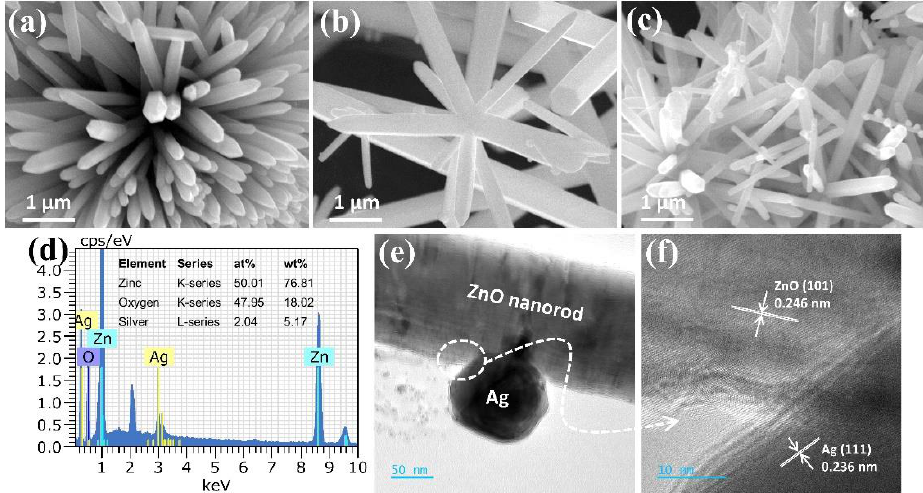
Figure 2. SEM image of pure ZnO ( a ), 2% Ag-ZnO ( b ), and 5% Ag-ZnO ( c ); EDX spectra of the 5% Ag-ZnO ( d ); low-magnification ( e ), and high-resolution ( f ) TEM images of 5% Ag-ZnO.